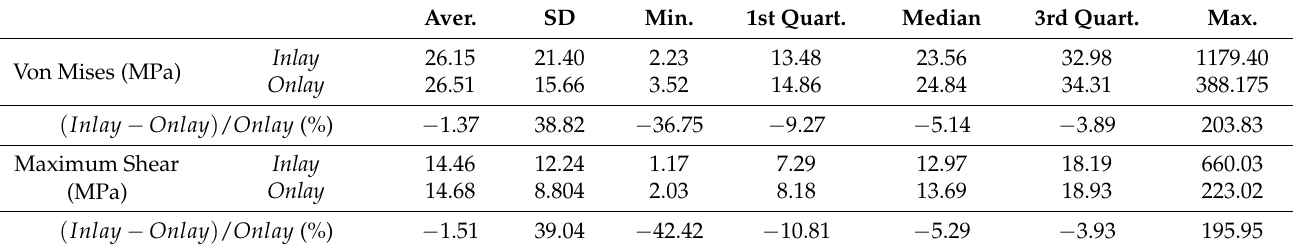
Table 8. Statistical description of the stress distributions for the enamel restorations.